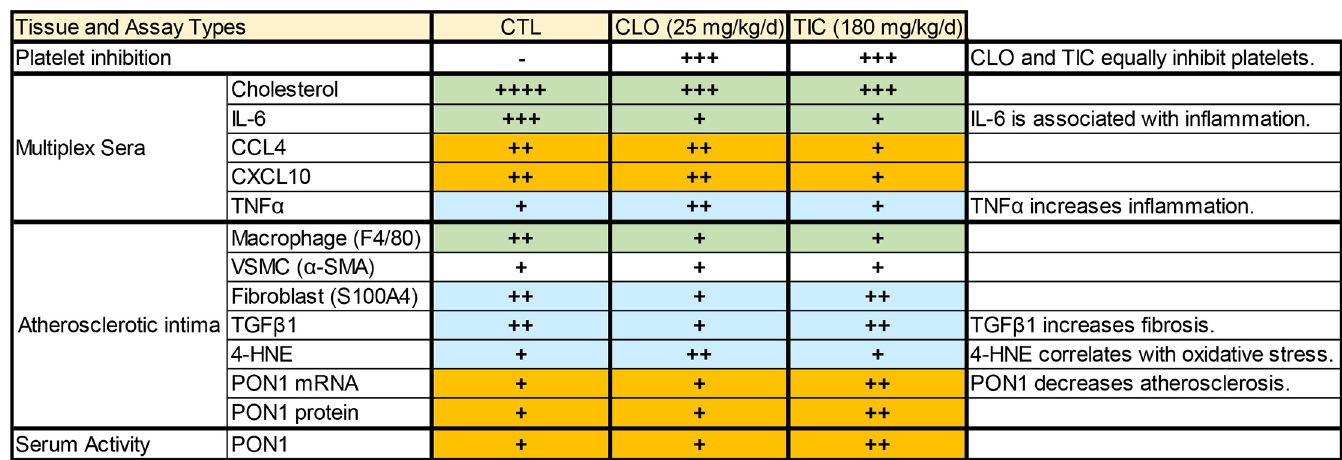
Fig 6. Biological phenotypes of CTL-, CLO-, and TIC-treated mice. Abbreviations: CTL, control; CLO, clopidogrel; TIC, ticagrelor; Orange, the results that could explain why TIC protects against atherosclerosis more than does CLO; Green, the results that could explain why TIC and CLO both protect against atherosclerosis, compared with CTL; Blue, the results that raise concerns on the possible negative vascular effects of CLO.